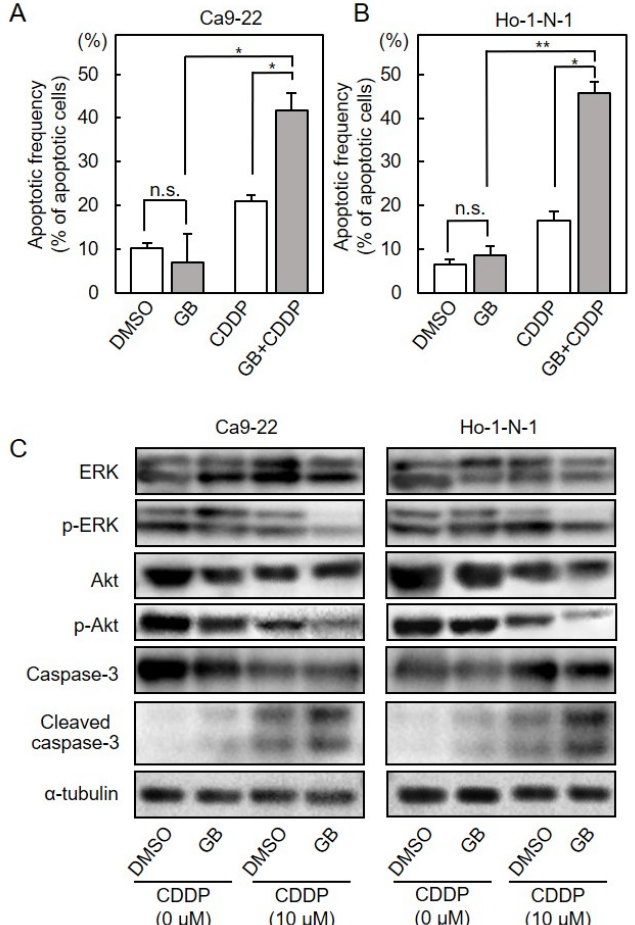
Figure 8. Effects of GB on CDDP sensitivity. ( A , B ) Flow cytometric assays of apoptosis in OSCC cells after treatment with GB, CDDP, and CDDP plus GB. Each represents mean values obtained from three separate experiments. Asterisks indicate statistical significance (Ca9-22 ( A ) and Ho-1-N-1 ( B ); Unpaired t -test; *, p < 0.05; **, p < 0.01; n.s., no significant difference). ( C ) Immunoblot analysis of the phosphorylation of ERK, phosphorylation of Akt, and cleaved caspase-3. In both Ca9-22 and Ho-1-N1, reduced phosphorylation of ERK and Akt and highly cleaved caspase-3 were observed in cells treated with CDDP plus GB combination therapy. α -tubulin protein levels were used as loading control. Detailed information about the Western blotting can be found at Figure S4 and Table